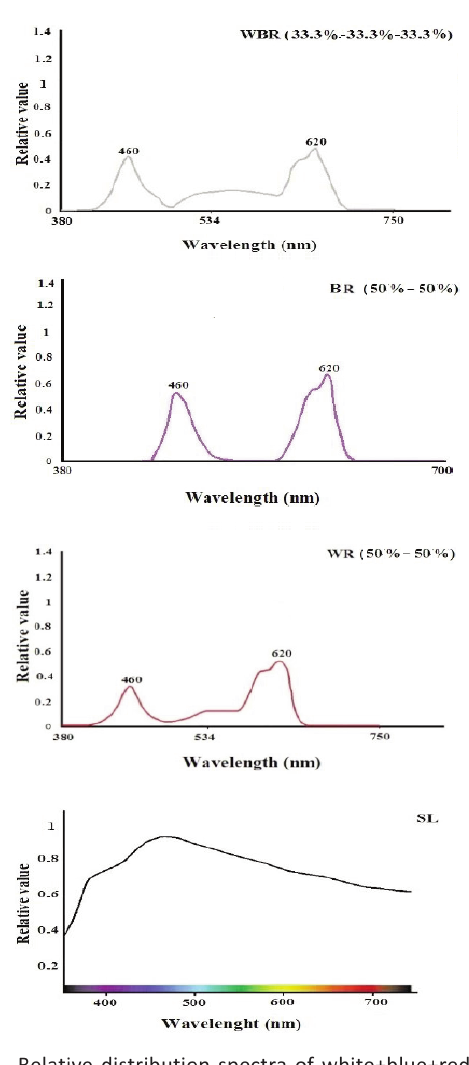
1 ­ Relative distribution spectra of white+blue+red (WBR), blue+red (BR), white+red (WR) and sunlight (SL) treat­ ments. Wavelength peaks are indicated by values above each